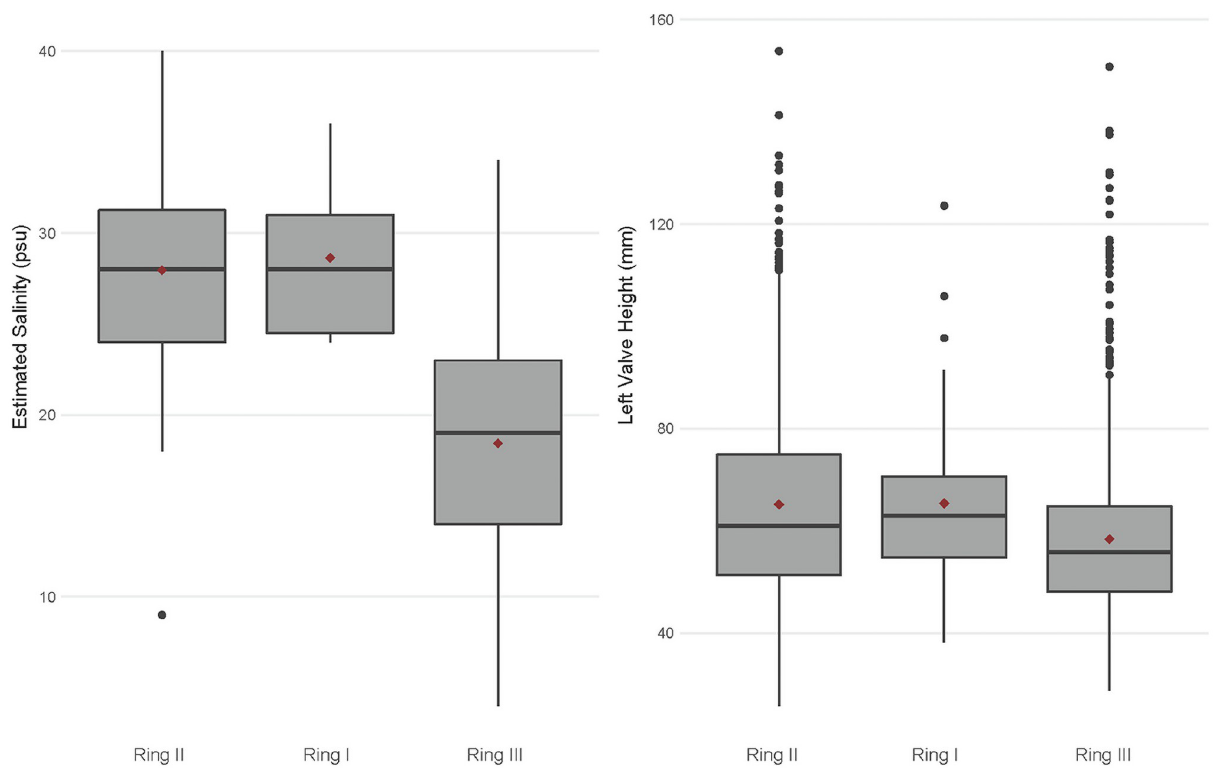
Fig 3. Box plots comparing (A) estimated salinity and (B) mean LVH between the three shell rings, showing significantly lower estimated salinity and smaller shells at Ring III. The shell rings are in chronological order based on the radiocarbon model, and red diamonds show mean values for each ring.